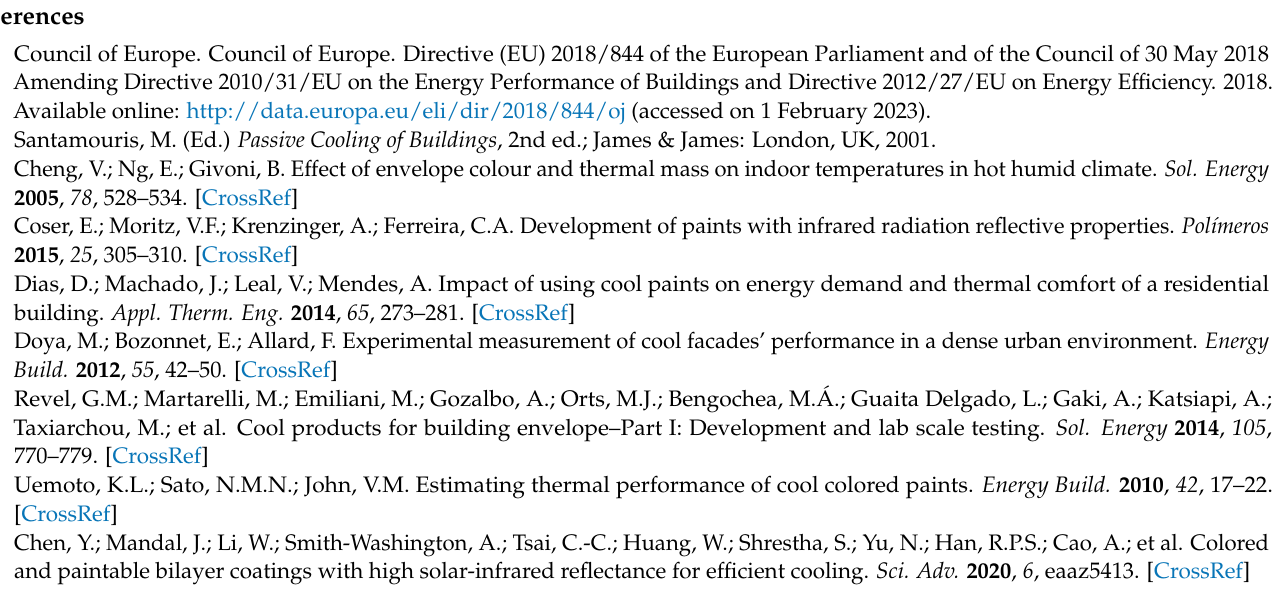
(Climate Bsh). Static simulation, s, dynamic simulation, d. Red, heating loads, blue, cooling loads. Figure S7. Annual loads in Lerida, Spain (Climate Bsk). Static simulation, s, dynamic simulation, d. Red, heating loads, blue, cooling loads. Figure S8. Annual loads in Las Vegas, USA (Climate Bwh). Static simulation, s, dynamic simulation, d. Red, heating loads, blue, cooling loads. Figure S9. Annual loads in Arequipa, Peru (Climate Bwk). Static simulation, s, dynamic simulation, d. Red, heating loads, blue, cooling loads. Figure S10. Annual loads in Atlanta, USA (Climate Cfa). Static simulation, s, dynamic simulation, d. Red, heating loads, blue, cooling loads. Figure S11. Annual loads in Paris, France (Climate Cfb). Static simulation, s, dynamic simulation, d. Red, heating loads, blue, cooling loads. Figure S12. Annual loads in Sao Paulo, Brazil (Climate Cwa). Static simulation, s, dynamic simulation, d. Red, heating loads, blue, cooling loads. Figure S13. Annual loads in City of Mexico, Mexico (Climate Cwb). Static simulation, s, dynamic simulation, d. Red, heating loads, blue, cooling loads. Figure S14. Annual loads in Barcelona, Spain (Climate Csa). Static simulation, s, dynamic simulation, d. Red, heating loads, blue, cooling loads. Figure S15. Annual loads in Porto, Portugal (Climate Csb). Static simulation, s, dynamic simulation, d. Red, heating loads, blue, cooling loads. Figure S16. Annual loads in New York, USA (Climate Dfa). Static simulation, s, dynamic simulation, d. Red, heating loads, blue, cooling loads. Figure S17. Annual loads in Kiev, Ukraine (Climate Dfb). Static simulation, s, dynamic simulation, d. Red, heating loads, blue, cooling loads. Figure S18. Annual loads in Beijing, China (Climate Dwa). Static simulation, s, dynamic simulation, d. Red, heating loads, blue, cooling loads. Figure S19. Annual loads in Edmonton, Canada (Climate Dwb). Static simulation, s, dynamic simulation, d. Red, heating loads, blue, cooling loads. Figure S20. Annual loads in Tabriz, Turkey (Climate Dsa). Static simulation, s, dynamic simulation, d. Red, heating loads, blue, cooling loads. Figure S21. Annual loads in Flagstaff, USA (Climate Dsb). Static simulation, s, dynamic simulation, d. Red, heating loads, blue, cooling